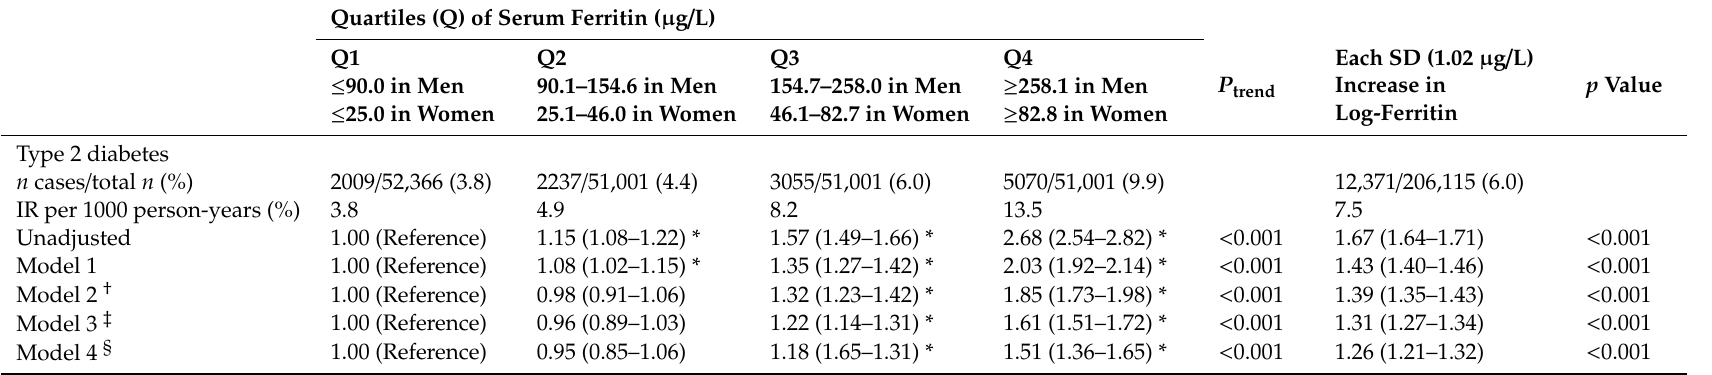
Table 3. Hazard ratios (HRs) (95% CIs) for incident type 2 diabetes according to sex-specific quartiles of serum ferritin during an 8.4-year